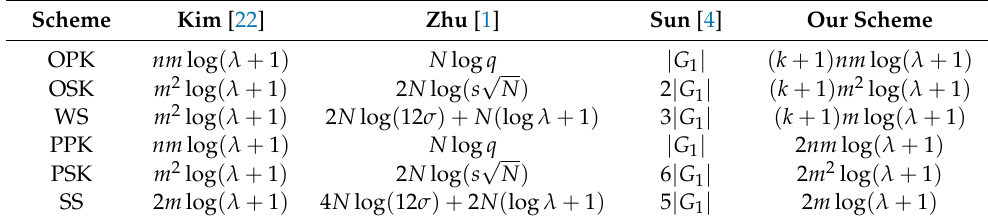
Table 2. A comparison of storage overheads.